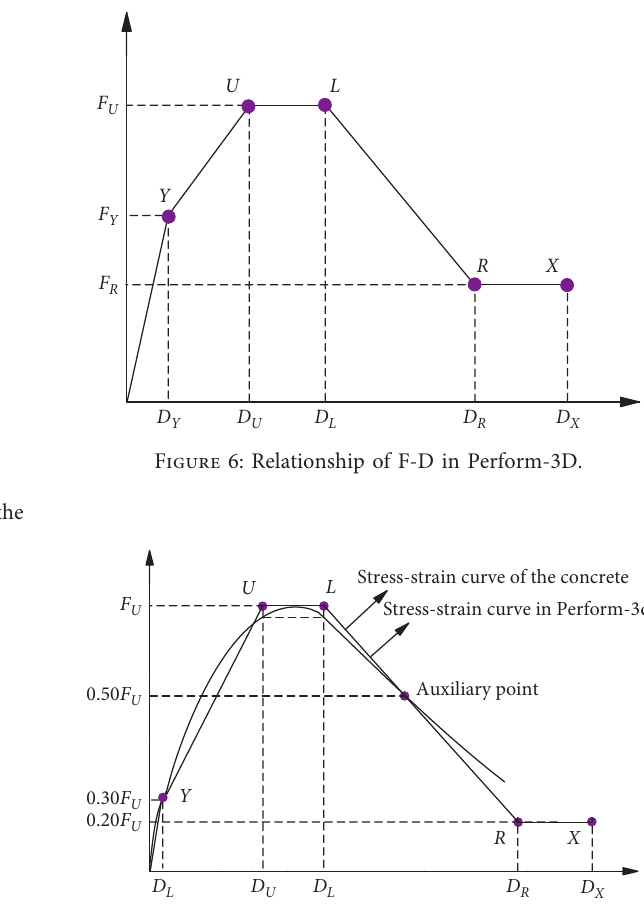
Figure 4: The stress-strain curve of the concrete.